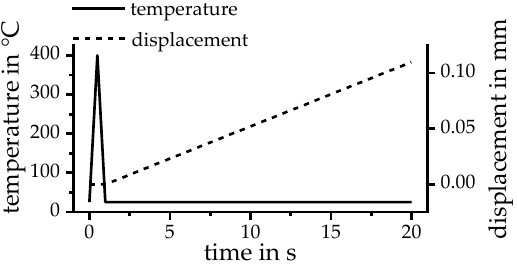
Figure 18. Exemplary time-temperature and time-displacement graph for checking the simulated transformation behavior and the resulting properties.